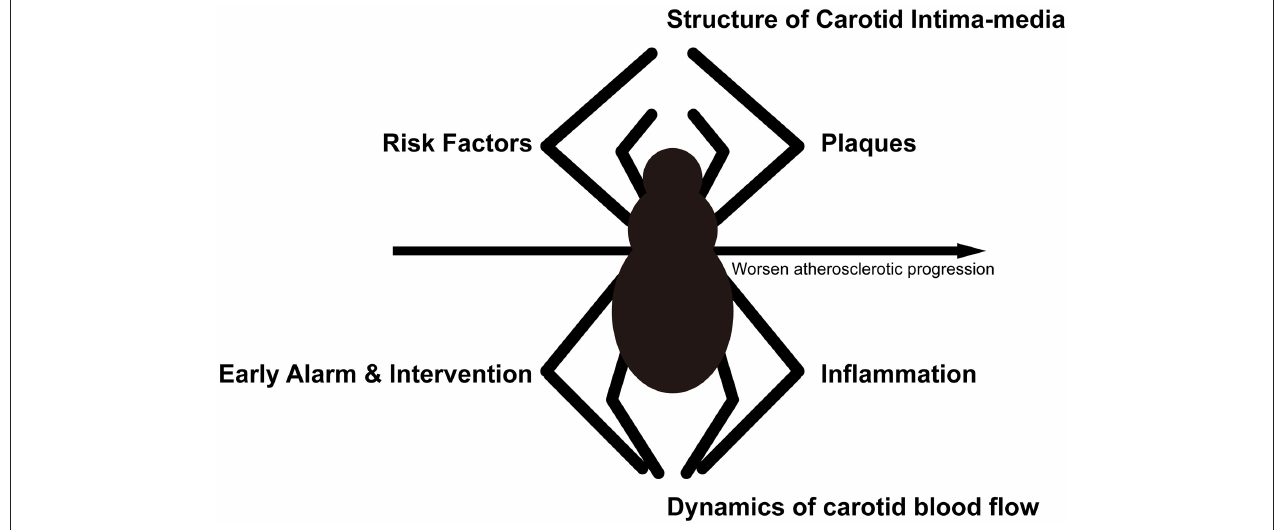
FIGURE 4 | Schematic diagram of the “SPIDER” proposal. The progression of atherosclerosis is similar to a spider spinning a web, and a full consideration of these 6 aspects may help to prevent the progression of